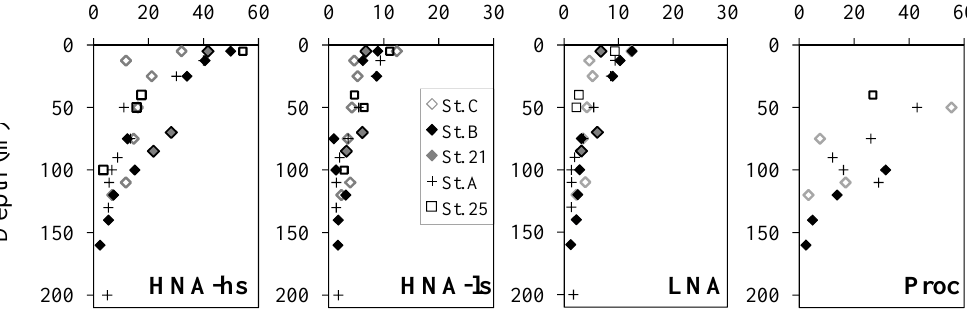
Fig. 4. Variability in cell-specific leucine incorporation rates for several cytometric groups (HNA-hs, HNA-ls, LNA and Proc). Each symbol corresponds to a different profile. Note that the rate scale varies according to the cytometric